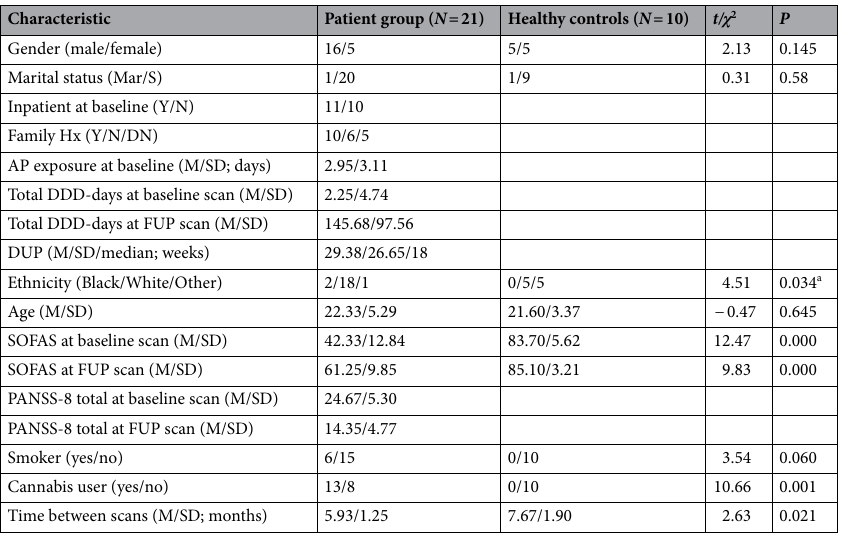
Table 1. Demographic and clinical characteristics. Mar married, S single, Y yes, N no, Hx history, DN don’t know, AP antipsychotic, M mean, SD standard deviation, DDD defined daily dose, FUP follow-up, DUP duration untreated psychosis. P values for differences between groups were calculated using chi-square analyses for categorical variables and independent t tests for continuous variables. a White vs non-White